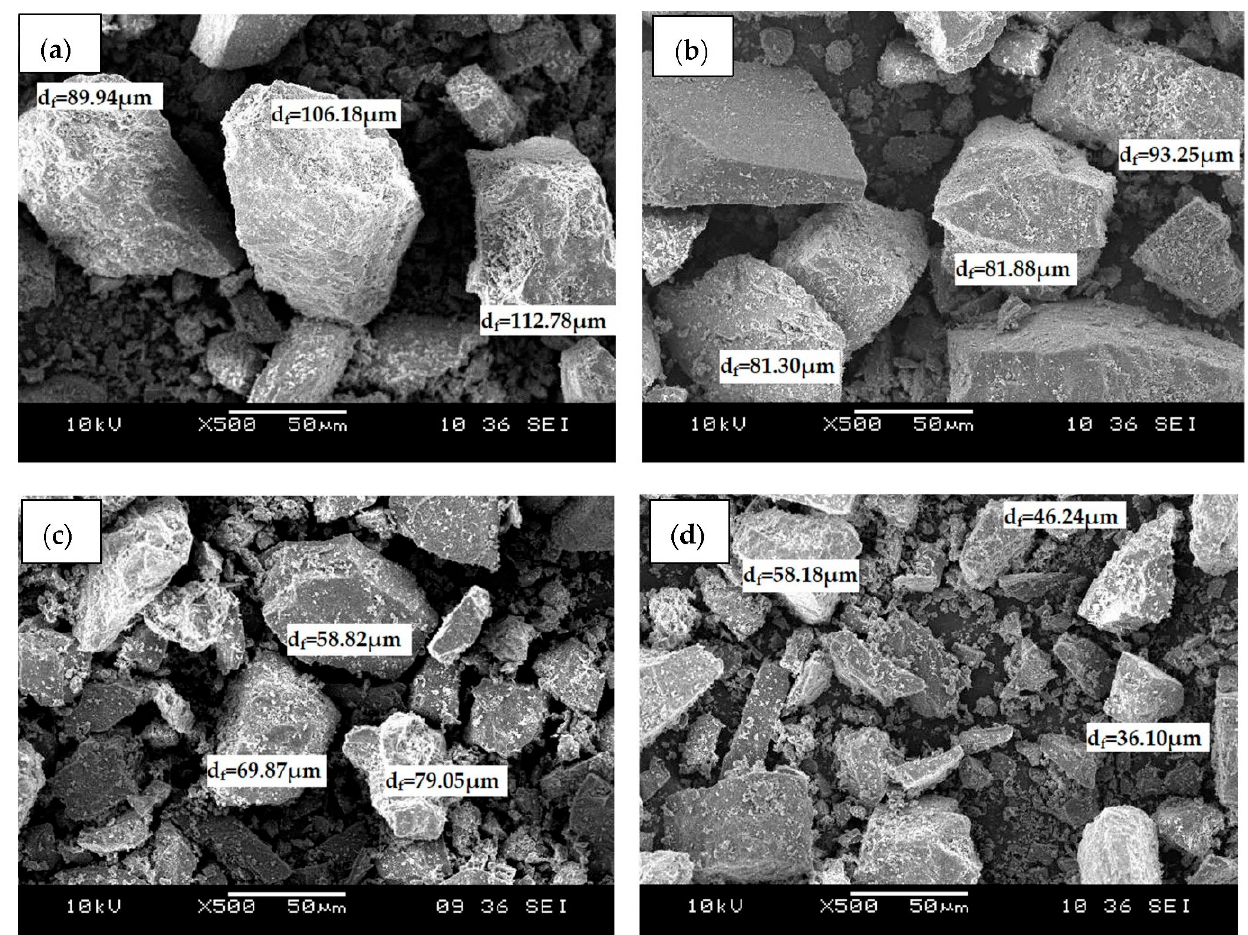
Figure 1. SEM micrographs of ( a ) raw dolomite (RD), ( b ) D 300 , (c) D 400 , and ( d ) D 500 at ×500 magnification.